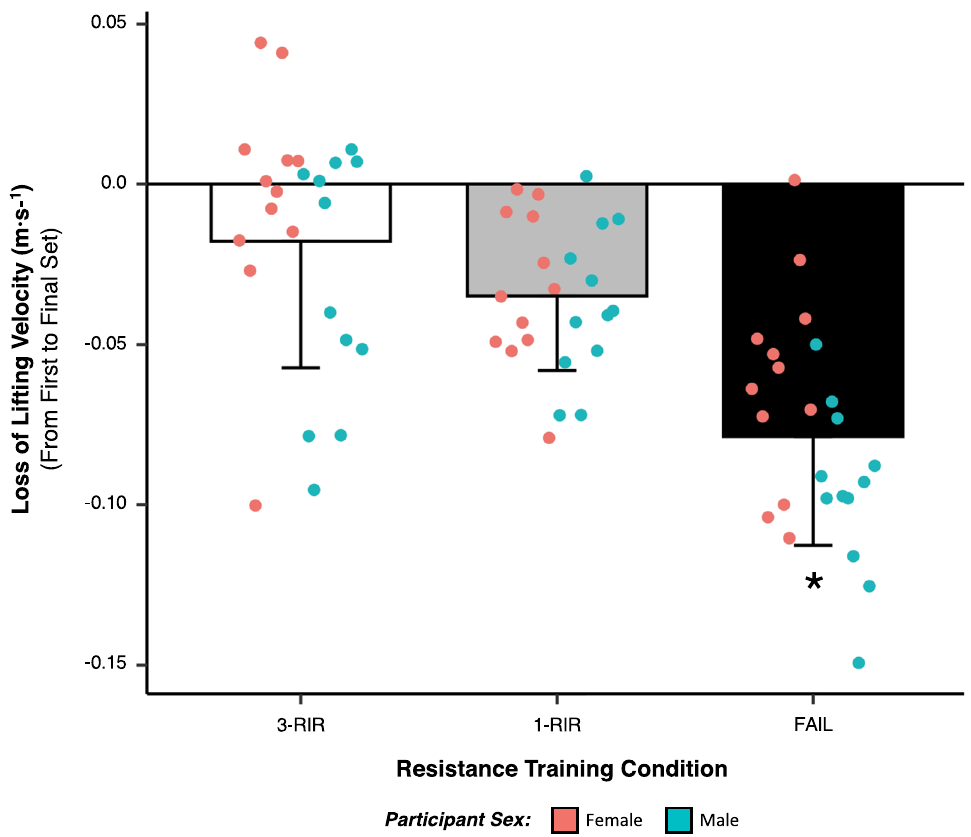
Fig. 5 Loss of lifting velocity from first to final set. Data shown are presented as absolute values (m s − 1 ) and as both protocol means ( individual values. *Denotes a statistically significant difference from 1-RIR and